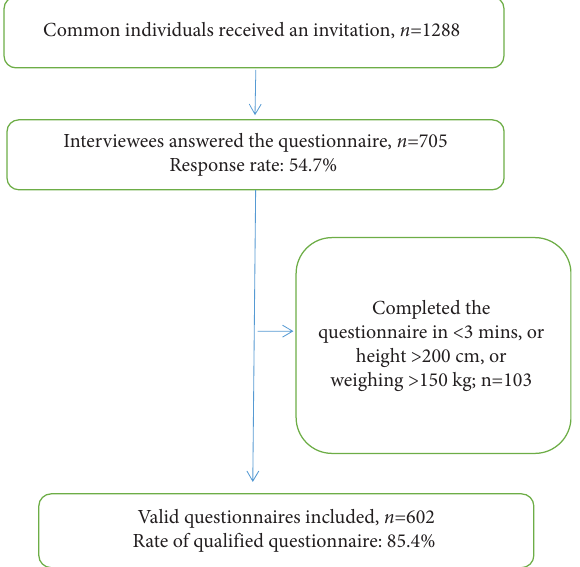
Figure 2: Flowchart of sample size determination